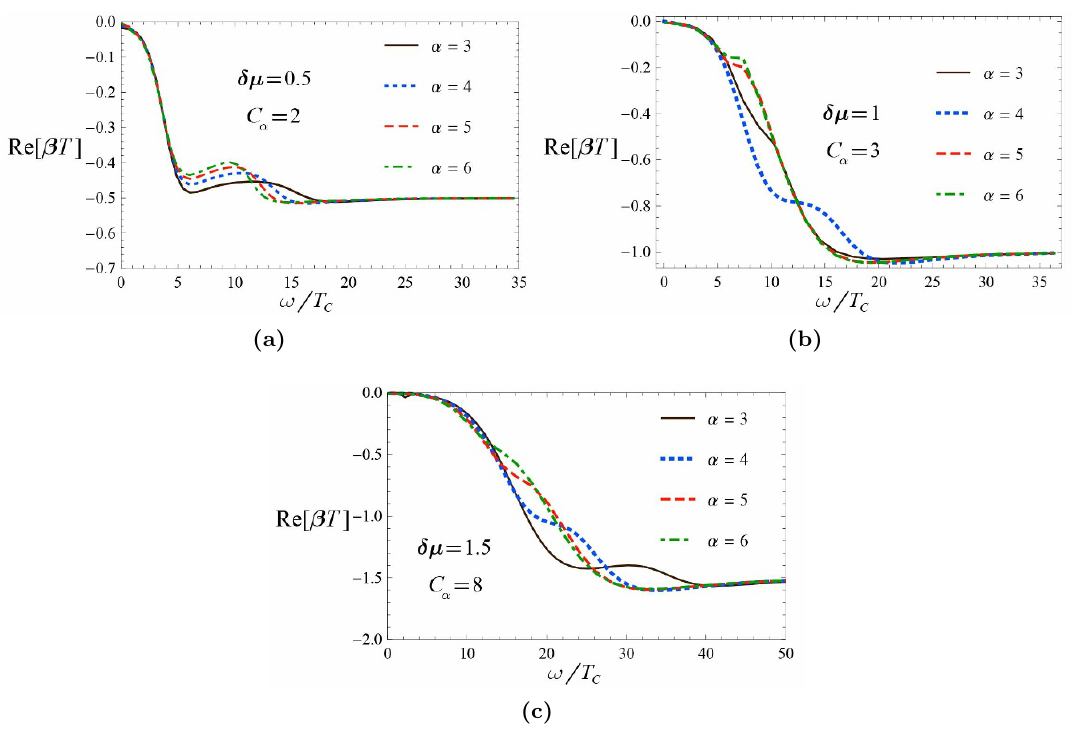
Figure 21. The real part of the thermo-spin conductivities in terms of !=T c for function F ( ) = 2 + C (cid:11) with (cid:11) = 3 ; 4 ; 5 ; 6 (solid curve, dotted curve, dashed curve, and dot-dashed (cid:11)